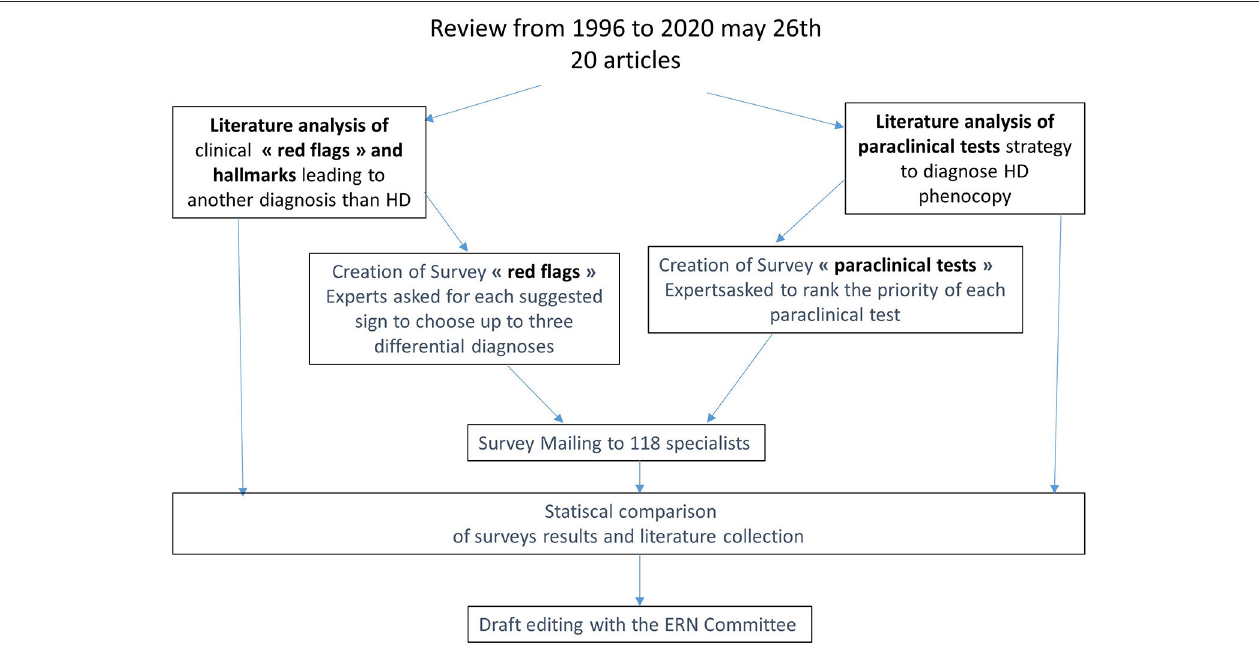
FIGURE 1 | Two complementary approaches, literature review, and surveys, to identify useful red flags and paraclinical tests to guide diagnosis.